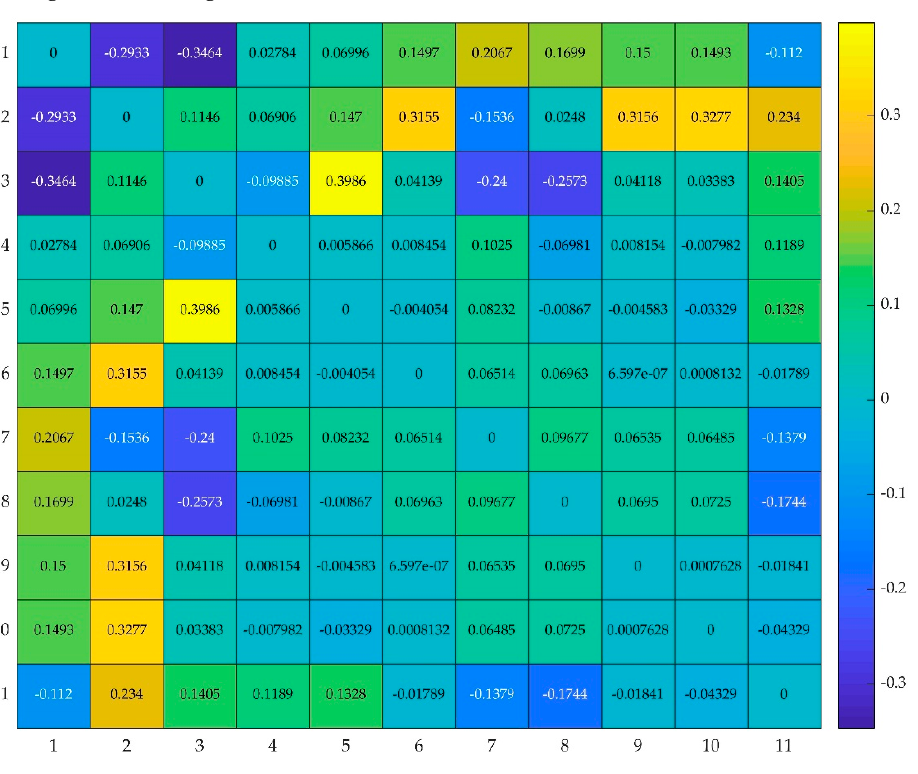
Figure 10. Di ff erences in the correlation coe ffi cients between Strategy 1 and Strategy Figure 10. Differences in the correlation coefficients between Strategy 1 and Strategy 2.